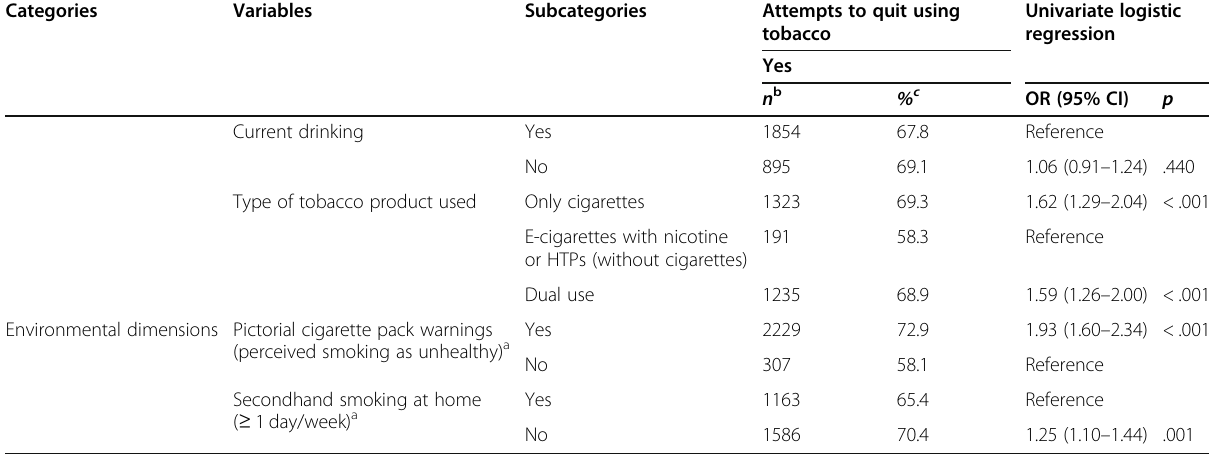
Table 2 Differences in attempts to quit using tobacco by related factors in adolescent tobacco users (Continued)